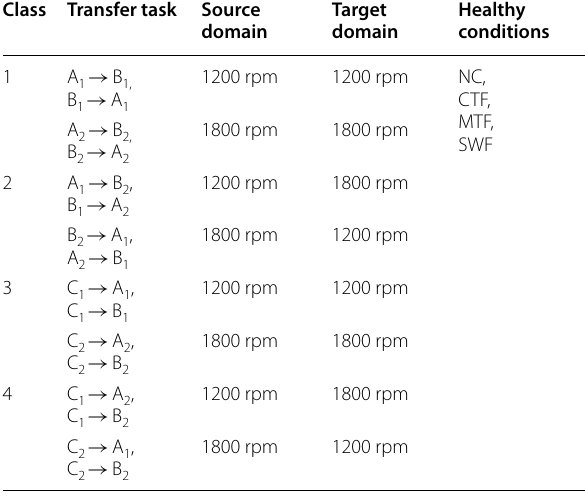
Table 2 Virous transfer